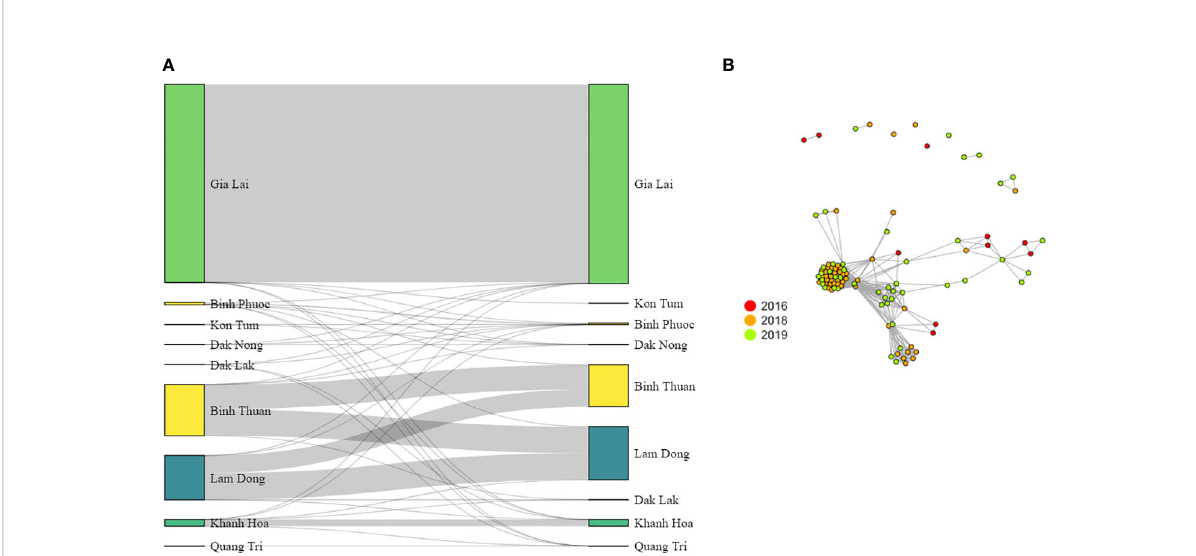
FIGURE 9 P. vivax parasite connectivity in Vietnam. (A) Summed pairwise IBD-sharing of isolates between and within provinces. (B) Connectivity networks inferred by IBD between P. vivax isolates from Gia Lai province. Edges connecting parasite pairs indicate that >60% of their genomes descended from a common ancestor without intervening recombination. Node colors indicate the year of